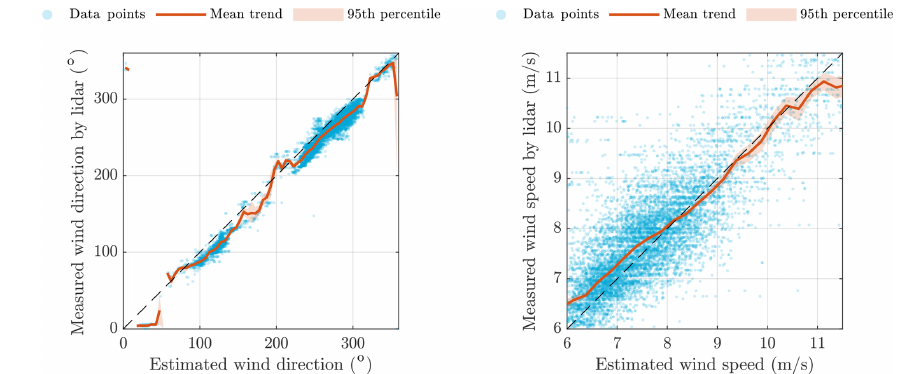
Figure 4. Comparison of wind direction and wind speed estimates from the lidar (10min averages) and from the turbine anemometers (1min averages). For the field campaign, the freestream wind direction, wind speed, and turbulence intensity at WTG 26 are estimated using upstream turbines WTG 25 and WTG 24. This approach is validated by comparing the estimates to measurements of the Leosphere WindCube V2 lidar, installed in front of WTG 26 throughout the first several months of the field campaign. The figure shows that the estimates largely match the measurements and the 95% uncertainty bounds, denoted by the shaded region, are narrow. Note that waked sectors (e.g., zone at 80–90 ◦ ) are not removed in these